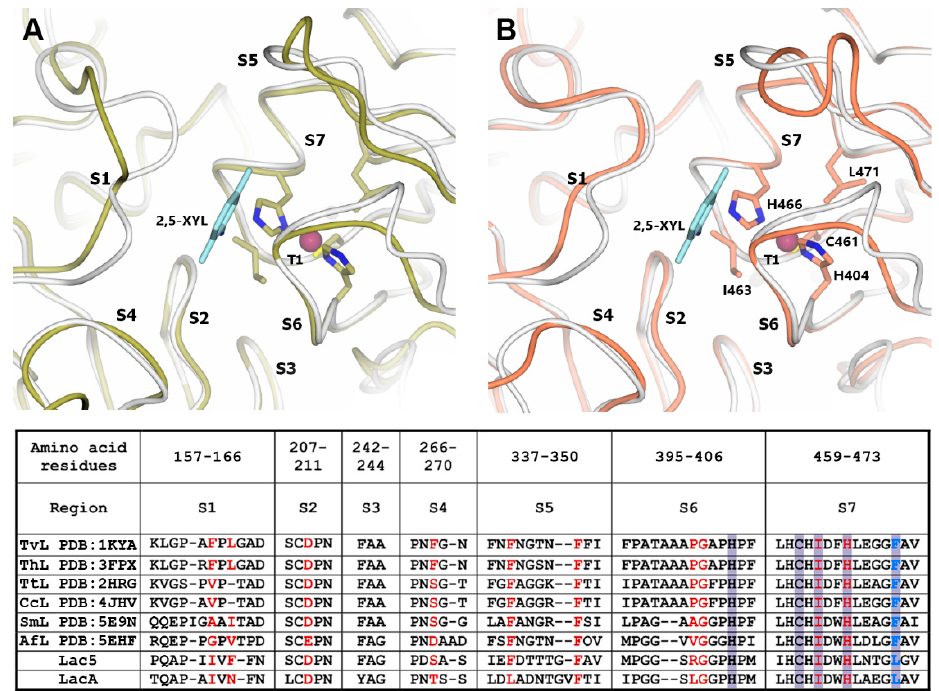
Figure 5. Three ‐ dimensional models of T1 active sites and their surroundings for Lac5 (A, yellow) and LacA (B, coral). Model of T. versicolor laccase complexed with 2,5 ‐ xylidine (PDB 1KYA, [70]) is shown in white. Copper ions are indicated as purple spheres. Side chains of the amino acid residues from the primary coordination sphere of the T1 copper ion are shown as stick models. Molecule of 2,5 ‐ xylidine is shown with light blue color. Alignment of the amino acid sequences of regions near the T1 active sites for laccases from T. versicolor (TvL), T. hirsuta (ThL), T. trogii (TtL), Coriolopsis caperata (CcL), S. murashkinskyi (SmL), and A. faginea (AfL) and P. lycii laccases Lac5 and LacA is presented in the table. Amino acid residues forming the substrate binding pocket identified according to the structures of T. versicolor laccase complexed with 2,5 ‐ xylidine and T. trogii laccase complexed with p ‐ toluate [71] are shown with red. Violet color indicates the residues from the primary coordination sphere of the T1 copper ion. Blue color indicates non ‐ conservative residue from the primary coordination sphere of the T1 copper ion. Amino acid numbering corresponds to the LacA sequence without the signal peptide.